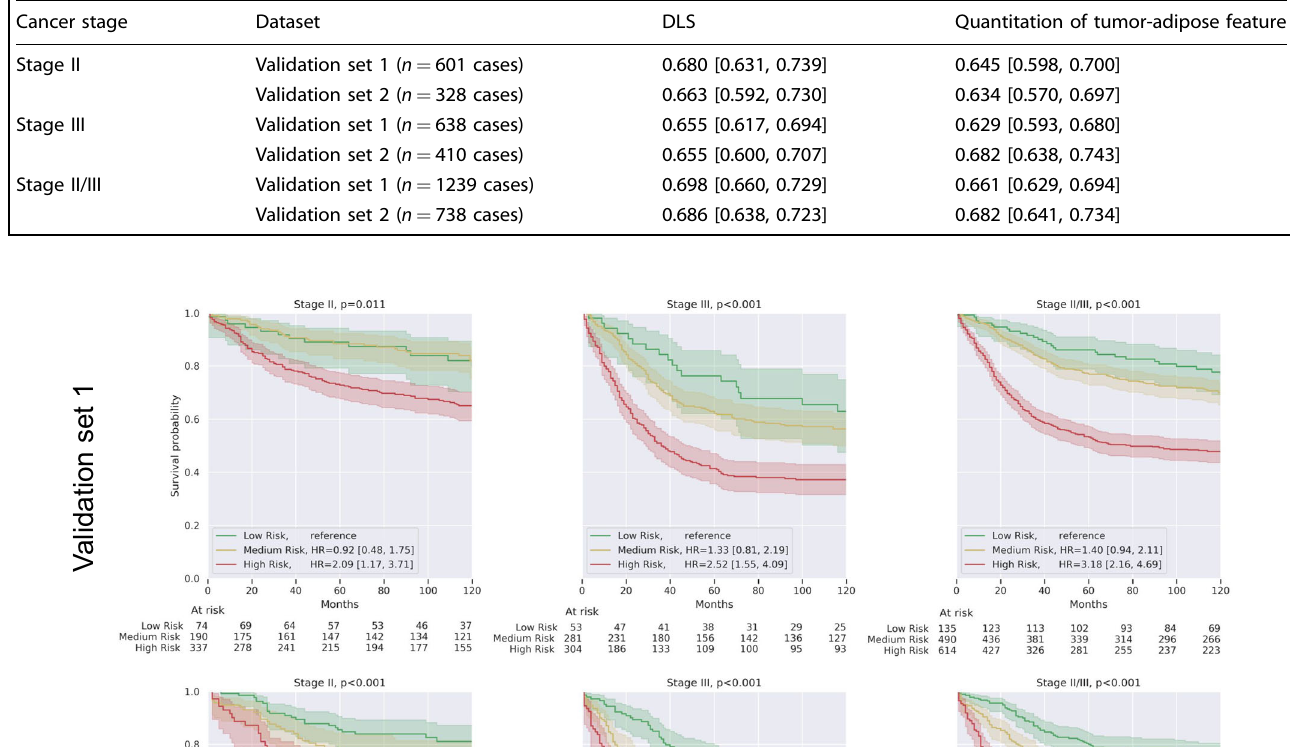
Table 2. The 5-year AUC for disease-speci fi c survival (DSS) prediction.